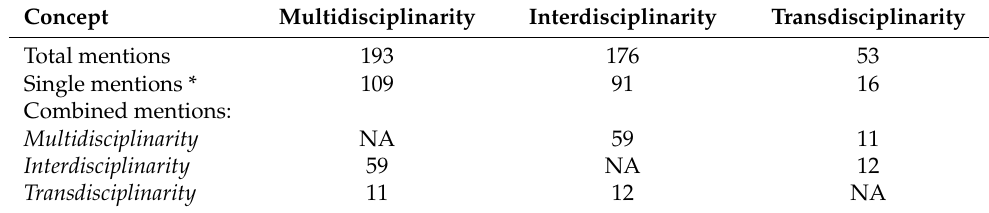
Table 1. Descriptive statistics of concept mentions across included articles ( n = 324).